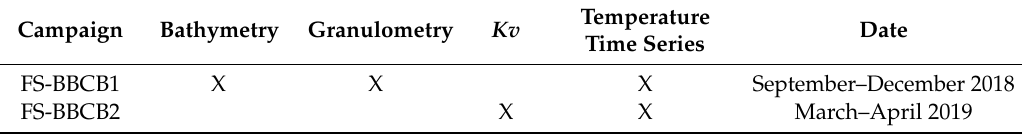
Table 1. Summary of field campaigns carried out at Baltimore Woods Nature Center. Campaign Bathymetry Granulometry Kv